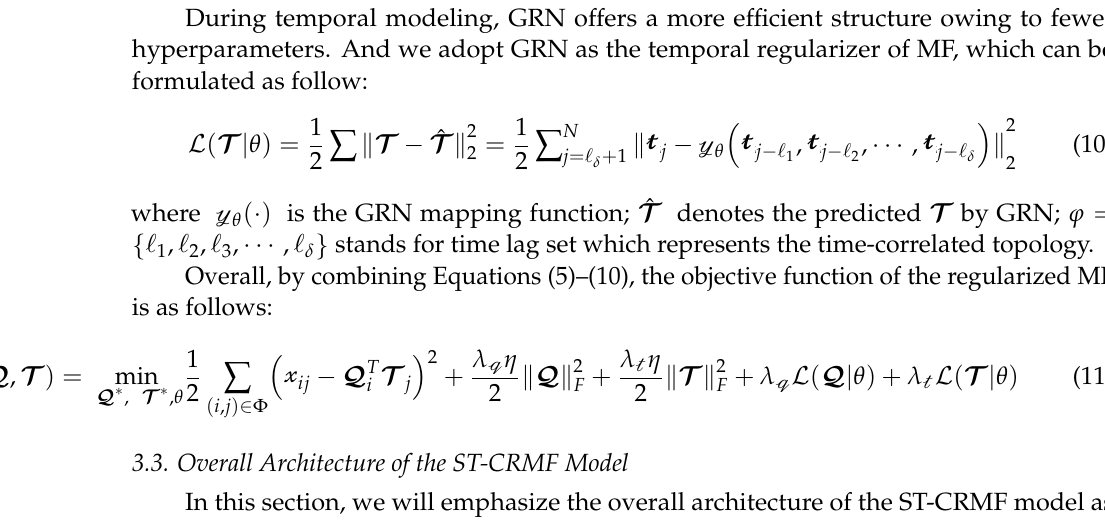
Figure 3. The structure of a GRN that consists of multiple GRU units.